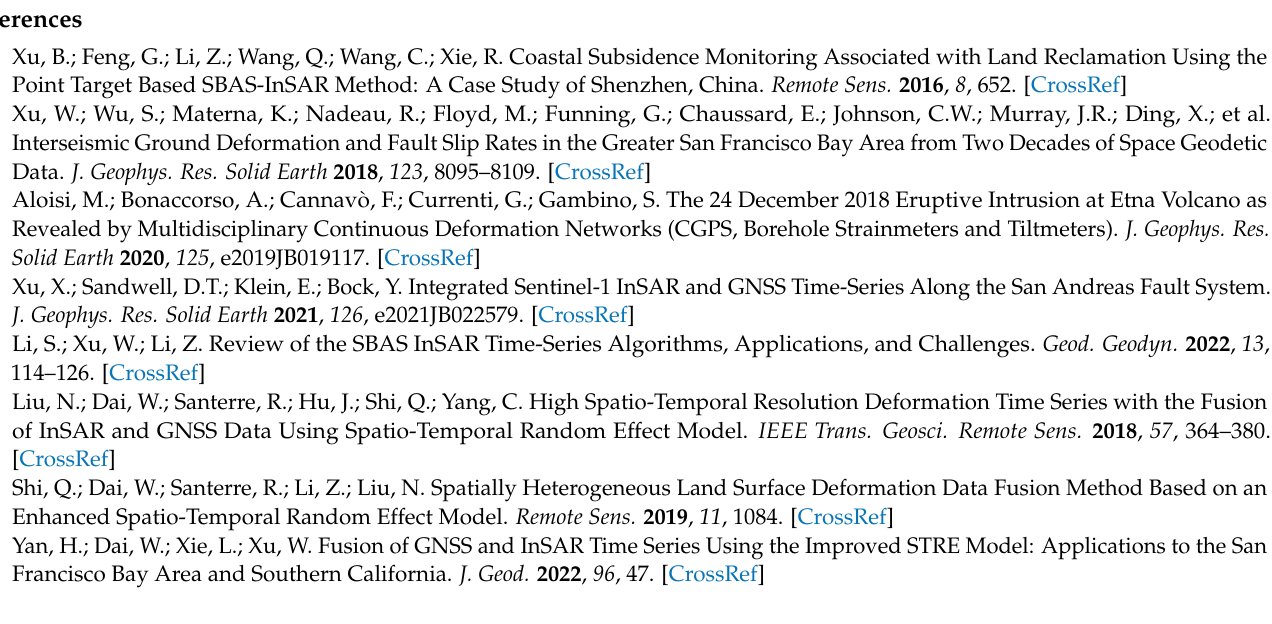
GNSS sites in CVAS. Figure S9c: The fusion results and original displacements in the LOS direction of other 38 GNSS sites in CVAS. Figure S10: The leave-one-out cross-validation results corresponding to the 48 periods InSAR displacement time series data relative to 8 November 2014 in CVAS. Figure S11: InSAR displacement residuals of leave-one-out cross-validation results in CVAS. Figure S12a: The leave-one-out cross-validation results and original displacements in the LOS direction of 37 GNSS sites in CVAS. Figure S12b: The leave-one-out cross-validation results and original displacements in the LOS direction of other 37 GNSS sites in CVAS. Figure S12c: The leave-one-out cross-validation results and original displacements in the LOS direction of other 38 GNSS sites in CVAS. Table S1: Date values corresponding to simulated InSAR data. Figure S13: The spatial distribution map of the triangular dislocation grid of the Cascadia subduction zone. Figure S14a: The spatial distribution of the slip rate (day 5 to day 80 in 15-day intervals) corresponding to the three experimental schemes. Figure S14b: The spatial distribution of the slip rate (day 10 to day 85 in 15-day intervals) corresponding to the three experimental schemes. Figure S14c: The spatial distribution of the slip rate (day 15 to day 90 in 15-day intervals) corresponding to the three experimental